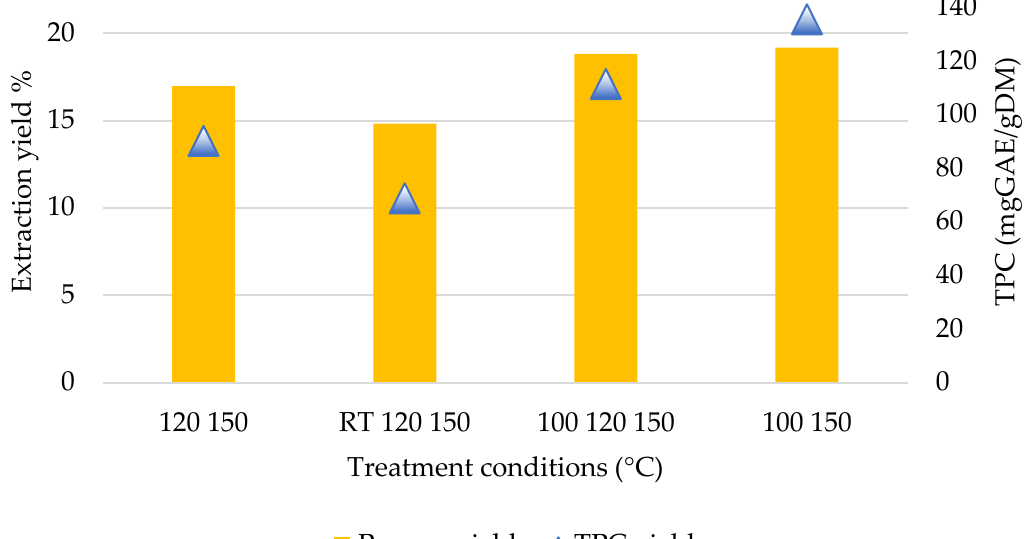
Figure 1. Comparison of the overall process yield and the total polyphenols’ extraction yield, between different investigated treatments.